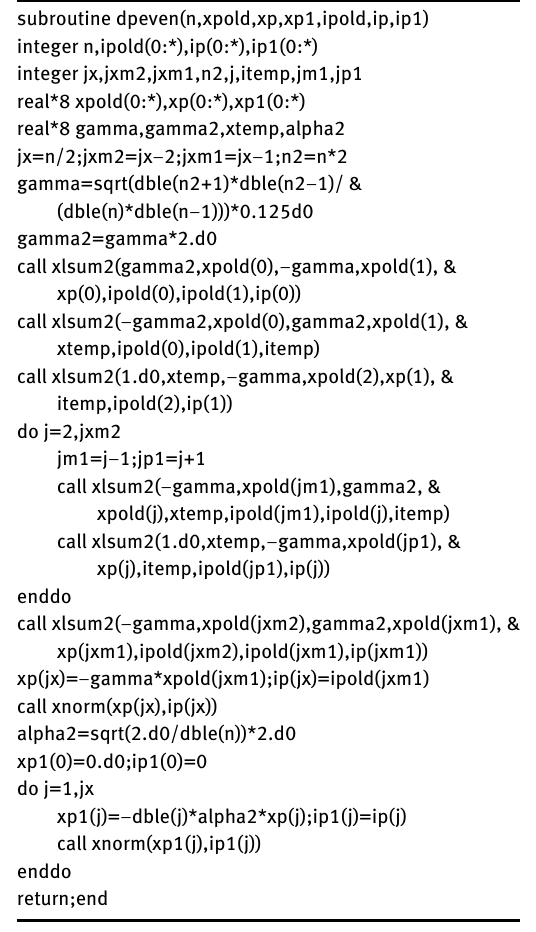
Table 4: Fortran subroutine to return P nnj and P n , n −1, j when de- gree n is even and n ≥ 6 . The returned values are ( xp ( j ), ip ( j )) and ( xp1 ( j ), ip1 ( j )) , double precision X-number vectors represent- ing P nnj and P n , n −1, j , respectively. We assume the availability of P n −2, n −2, j as ( xpold ( j ), ipold ( j )) . The subroutine internally calls xnorm and xlsum2 listed in Tables 7 and 8 of Fukushima (2012a), respectively.